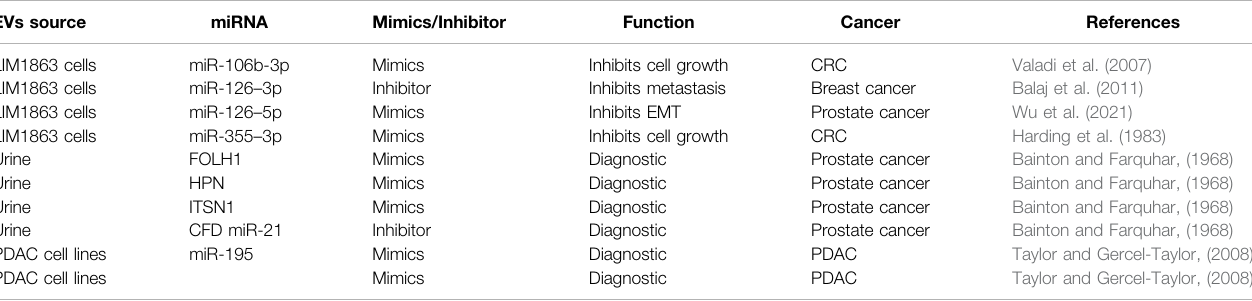
TABLE 2 | The miRNA of EVs in